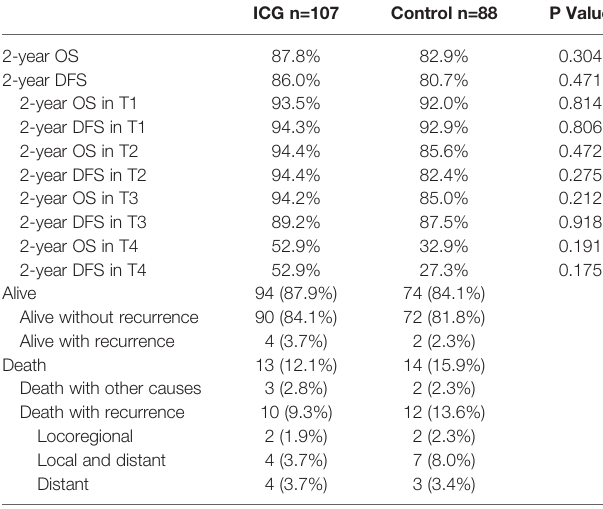
TABLE 5 | Patients ’ status at last